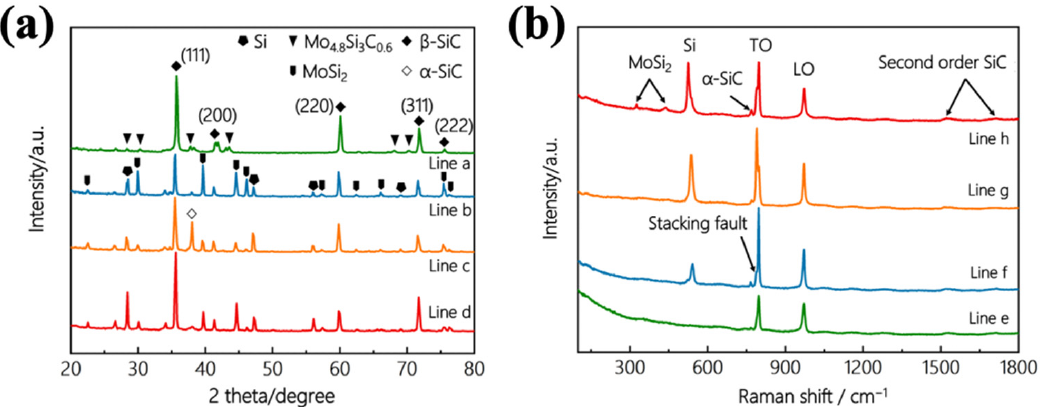
Figure 1. ( a ) XRD patterns of the SiC/MoSi 2 -SiC-Si coatings with different Si/Mo ratio: a, 1:1; b, 3:1; c, 5:1; d, 7:1. ( b ) Raman patterns of the coatings with different Si/Mo ratio: e, 1:1; f, 3:1; g, 5:1; h, 7:1.